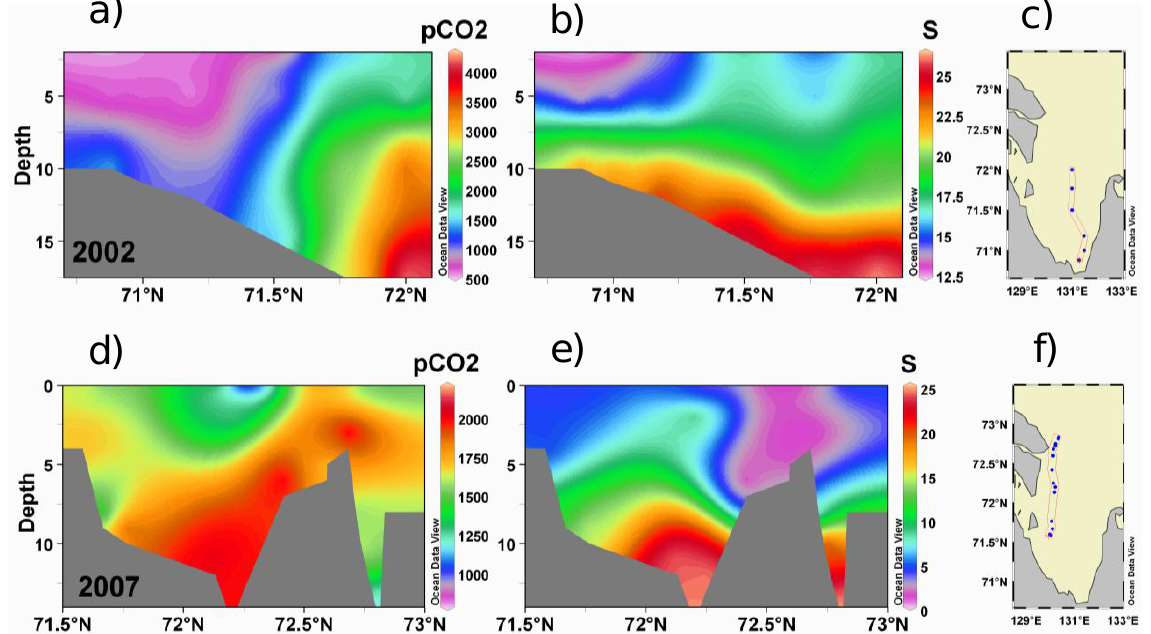
Fig. 12. Vertical distribution of CO 2 partial pressure ( p CO 2 , µatm) ( a , 2002; d , 2007) and salinity ( b , 2002; e , 2007) in the water column observed in the Buor-Khaya Bay in the winters of 2002 and 2007. Positions of transects are shown in (c) (2002) and (f)